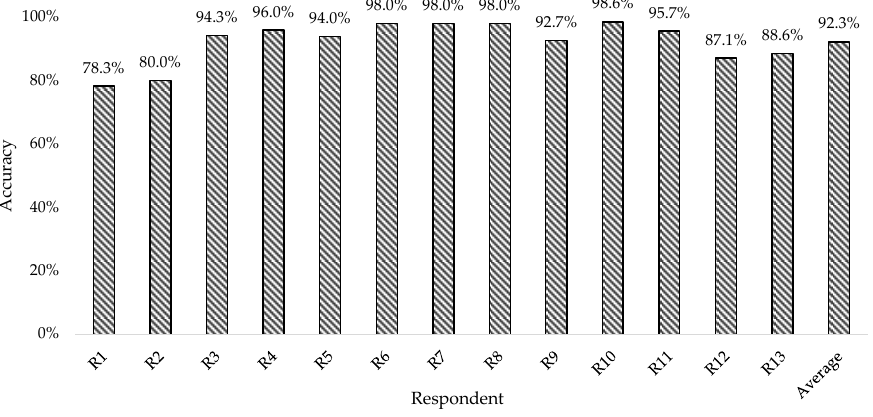
Figure 10. Accuracy of speech recognition of different respondents.